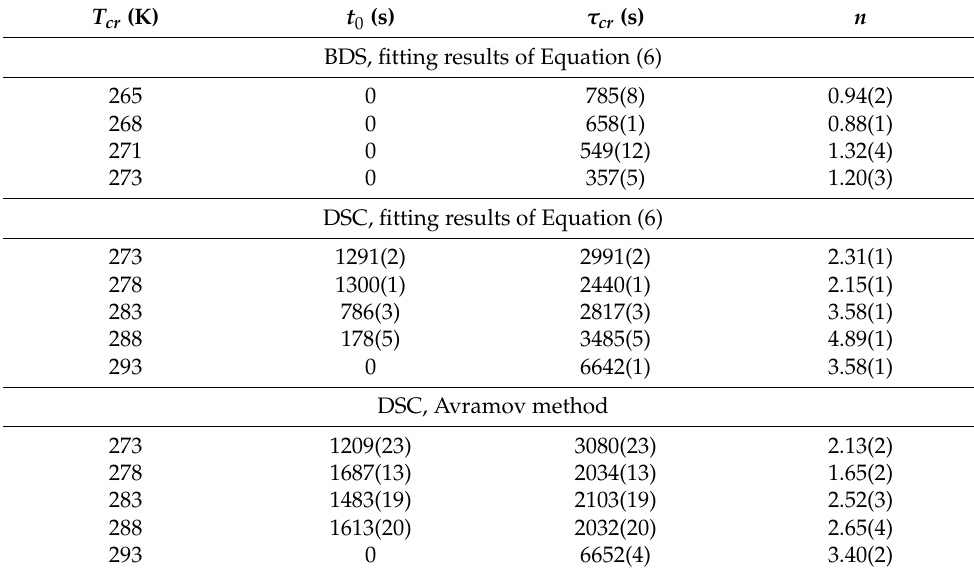
Table 3. Initialization time t 0 , characteristic time τ cr and Avrami exponent n of the isothermal cold crystallization of 3F7FPhH6 investigated by BDS and DSC. For results obtained by fitting Equation (6), A = 0.93 for 271, 273 K and A = 1 for other